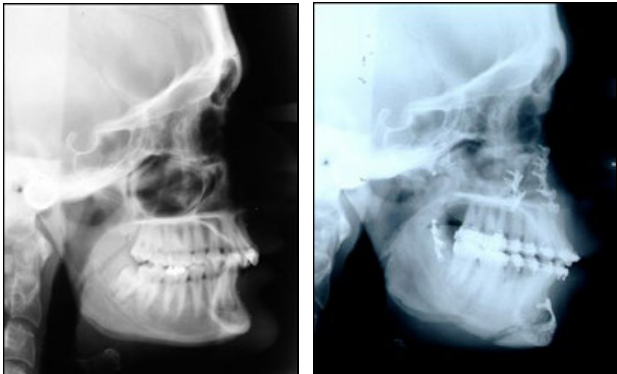
Figure 2. Pre-surgical and post-surgical cephalograms of a patient treated by clockwise rotation of the occlusal plane.